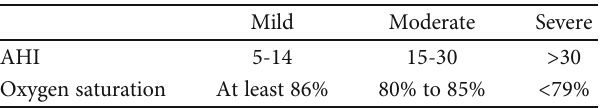
Table 2: Based on the Apnea-hypopnea index (AHI), and oxygen saturation category for the sleep apnea can be categorized into 3